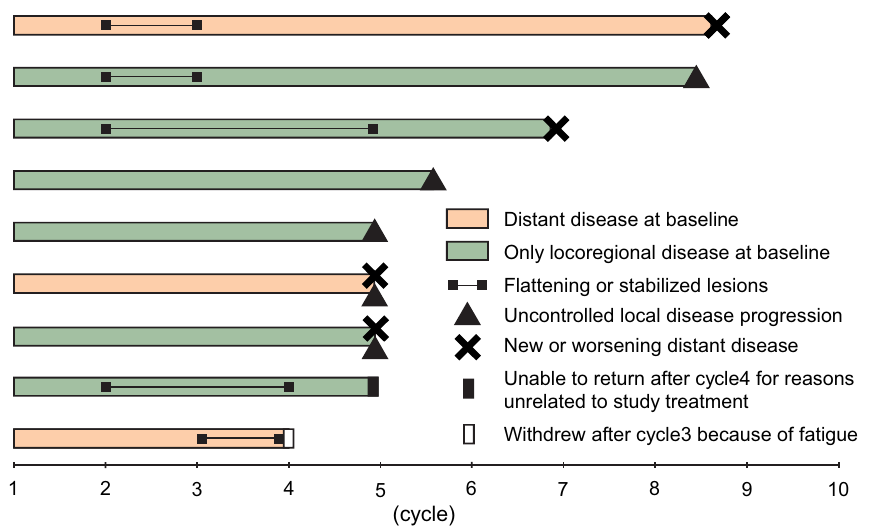
Figure 1. Swimmer plot showing clinical response for each patient. Each bar represents an individual